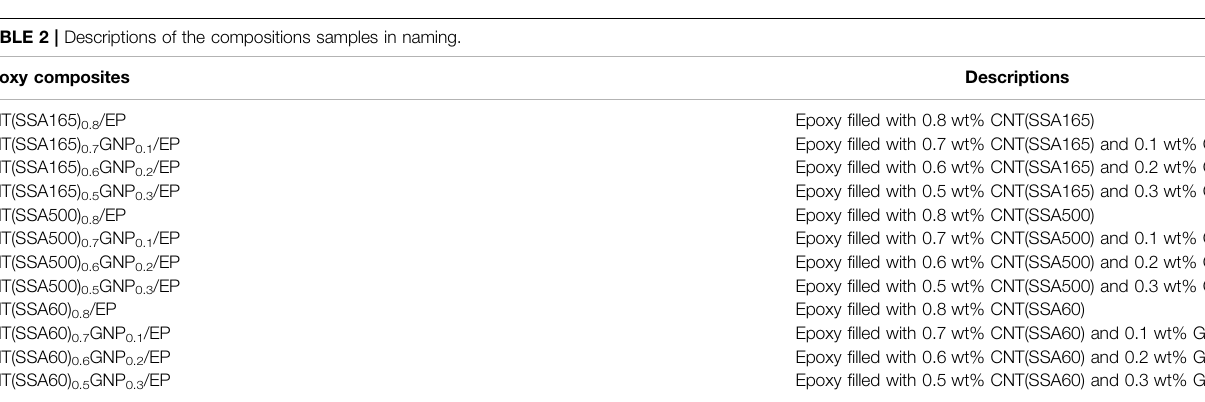
TABLE 2 | Descriptions of the compositions samples in